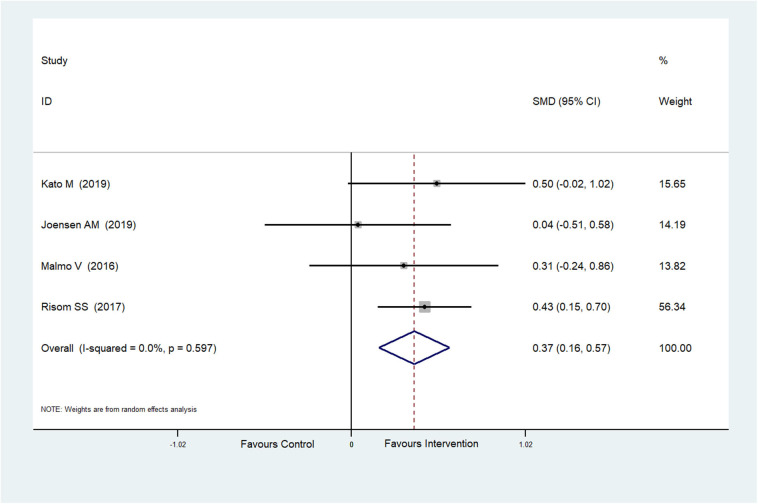
Forest plot shows the ES of physical exercise on peak VO2 in AF patients.